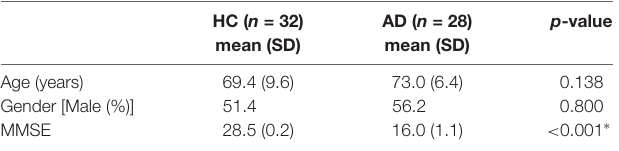
TABLE 1 | Subjects’ demographic and neuropsychological data.